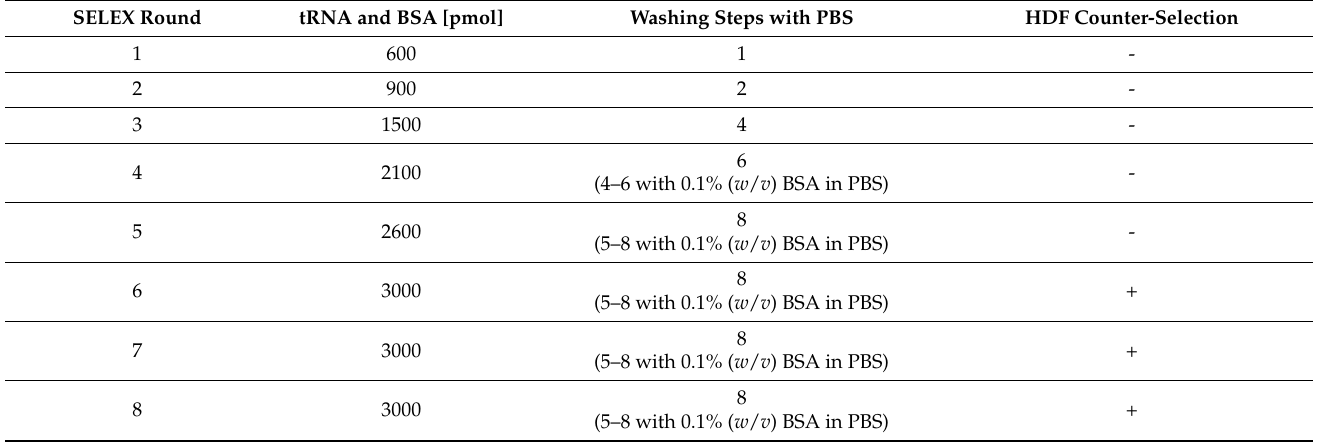
Table 1. Overview of SELEX round 1 to 8 with used tRNA and BSA concentrations during target selection round and washing steps after target selection round. Round 1 to 5 were individual aptamers for C. albicans , C. auris and C. parapsilosis , from round 6 on, HDF cells were used for counter selection, Candida mixture for target